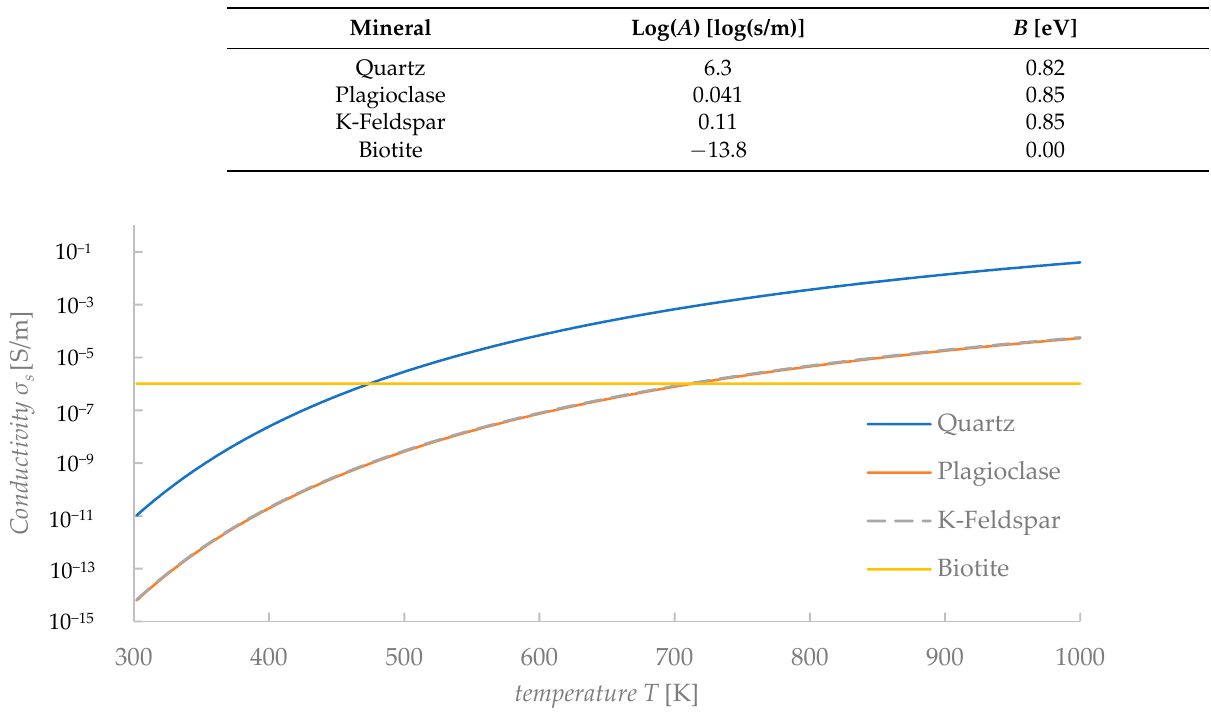
Figure 3. Calculated values of conductivity of minerals versus temperature.